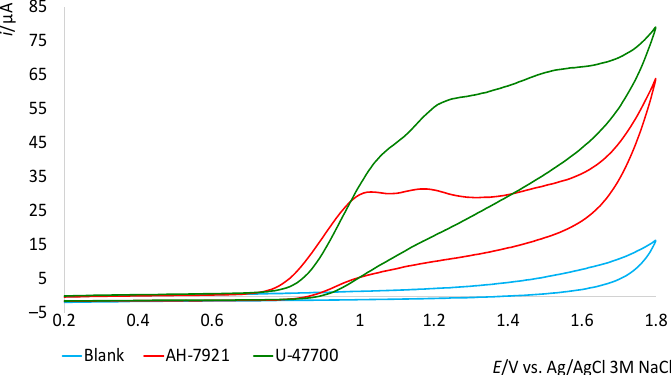
Figure 2. Cyclic voltammetry of U-47700 and AH-7921, 2.5 mM in ethanol/0.1 M lithium perchlorate and 0.10 M 2,6-lutidine. Potentials are referred to Ag/AgCl, 3 M NaCl. Scan speed: 50 mV·s − 1 . Working electrode: glassy carbon, 2 mm diameter. Other conditions described in the text.